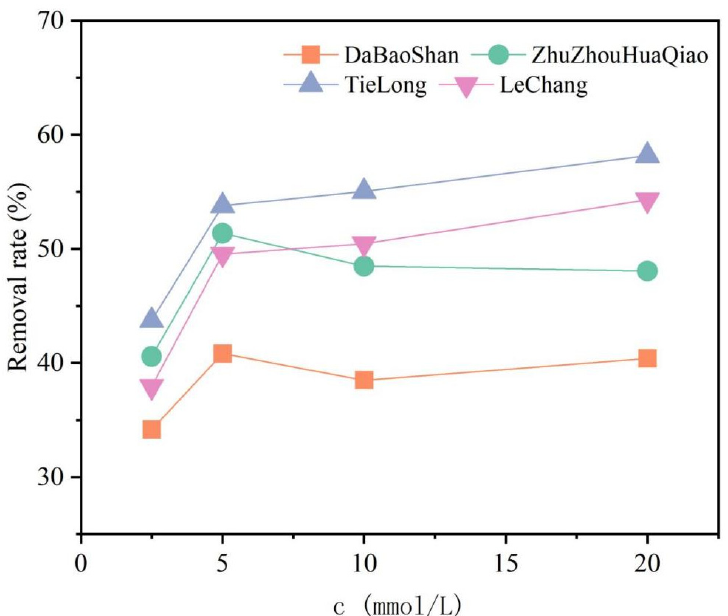
Figure 4. The leaching removal rate of Pb varies with the concentration of GLDA-Na with a pH of 4 after 120 min.